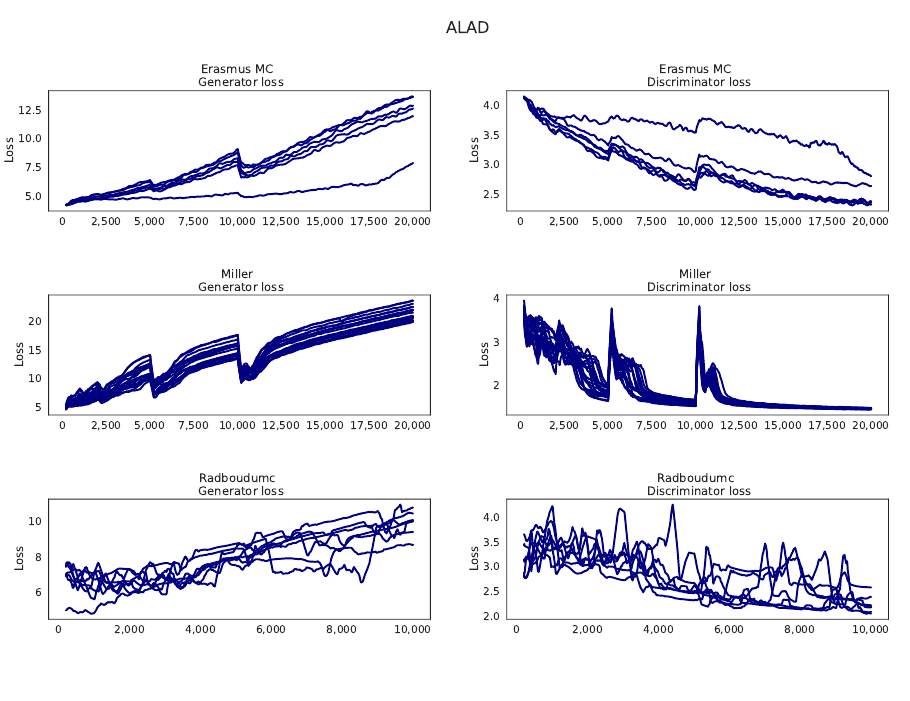
Figure A9. Learning curves for the ALAD method. The generator and discriminator loss are displayed in each subplot. Note that each curve represents one